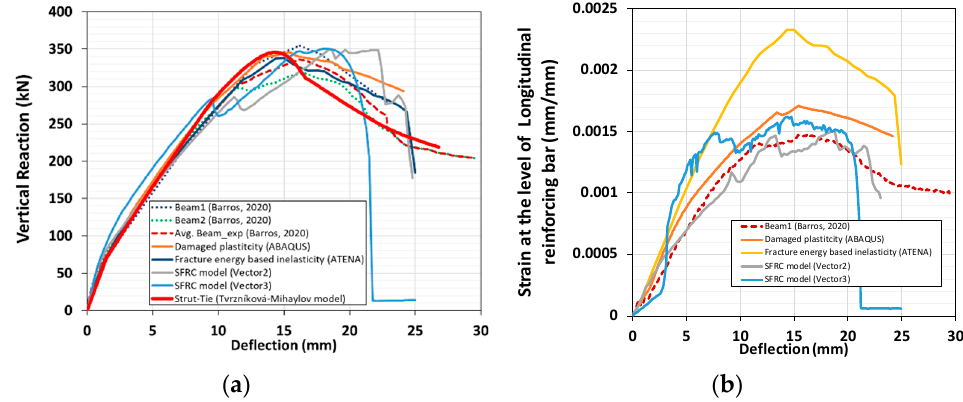
Figure 13. Shear capacities: ( a ) Load-deflection curve. ( b ) Strain curve at the level of the bottom reinforcement.